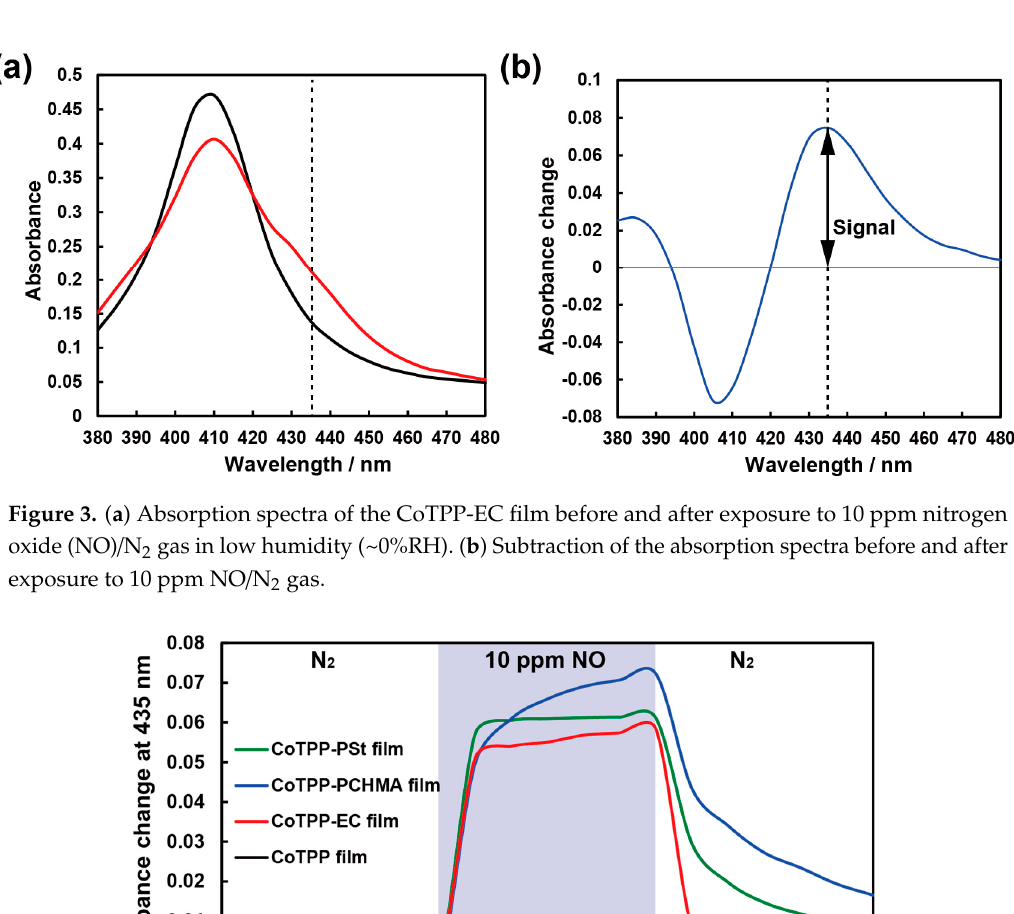
5 of 10 Figure 2. UV-vis absorbance spectra of CoTPP solution (black dotted line), CoTPP film (black solid line), CoTPP-EC film (red solid line), CoTPP-PSt film (green solid line), and CoTPP-PCHMA film (blue solid line) under nitrogen (N 2 ) atmosphere. 3.3. Sensor Responses to NO Gas Figure 3a shows the typical absorption spectral change before and after NO gas exposure. When